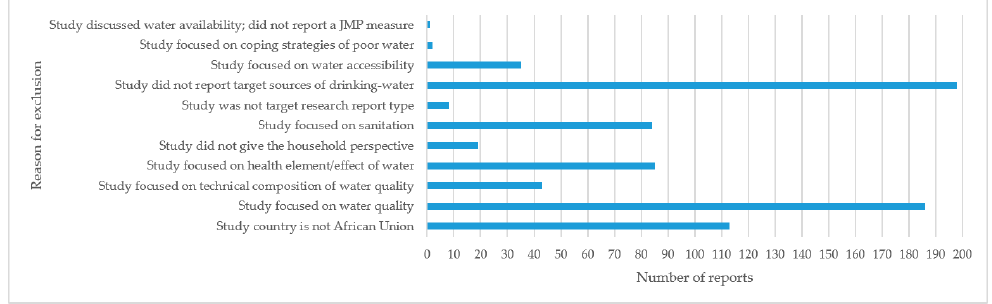
Figure A1. Reasons for reports being excluded at the screening stage. (NB: excluded from figure are reports which did not meet any inclusion criteria ( n = 1490).